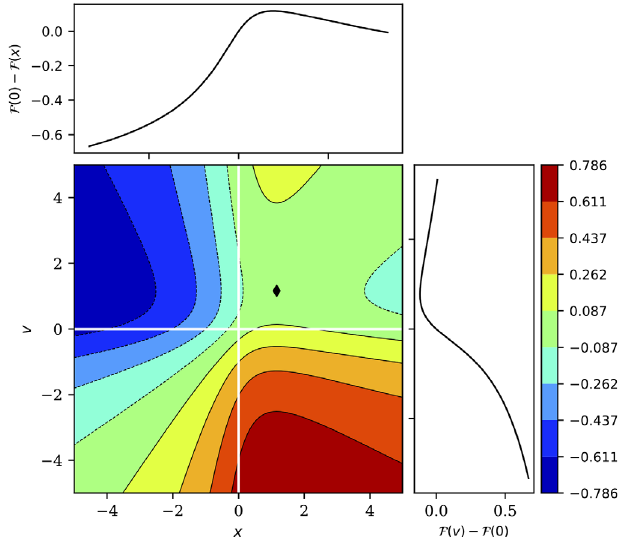
FIG. 10. Graphical representation of the exponent in Eq. (A13). The function F ð v Þ − F ð x Þ is stationary at x ¼ v ¼ α ; this point is a maximum for x and a minimum for v . Parameters are as in Fig. 8. In this figure, α ¼ 1 . 2 (black